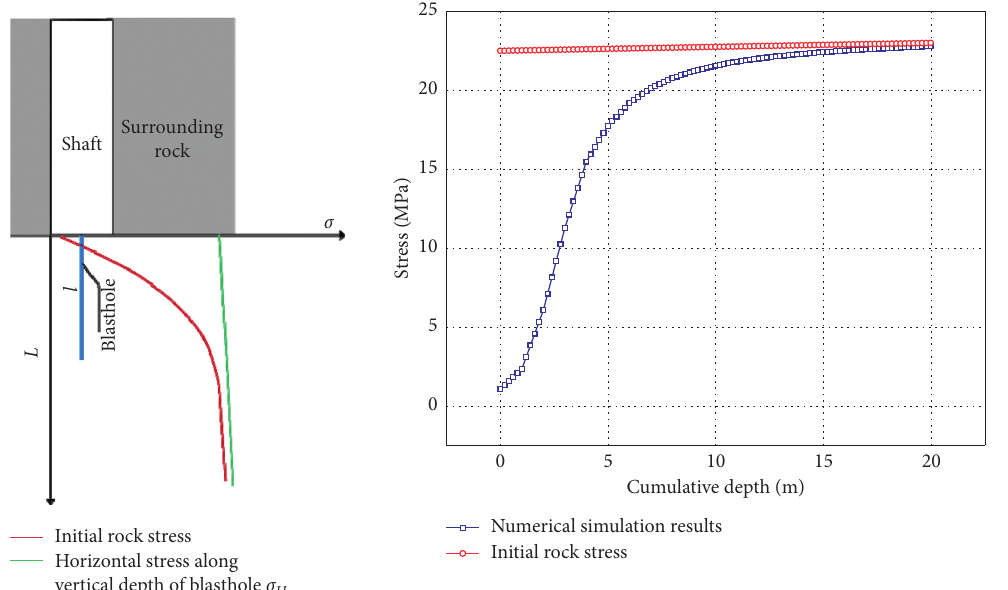
Figure 2: Vertical stress distribution and vertical stress simulation